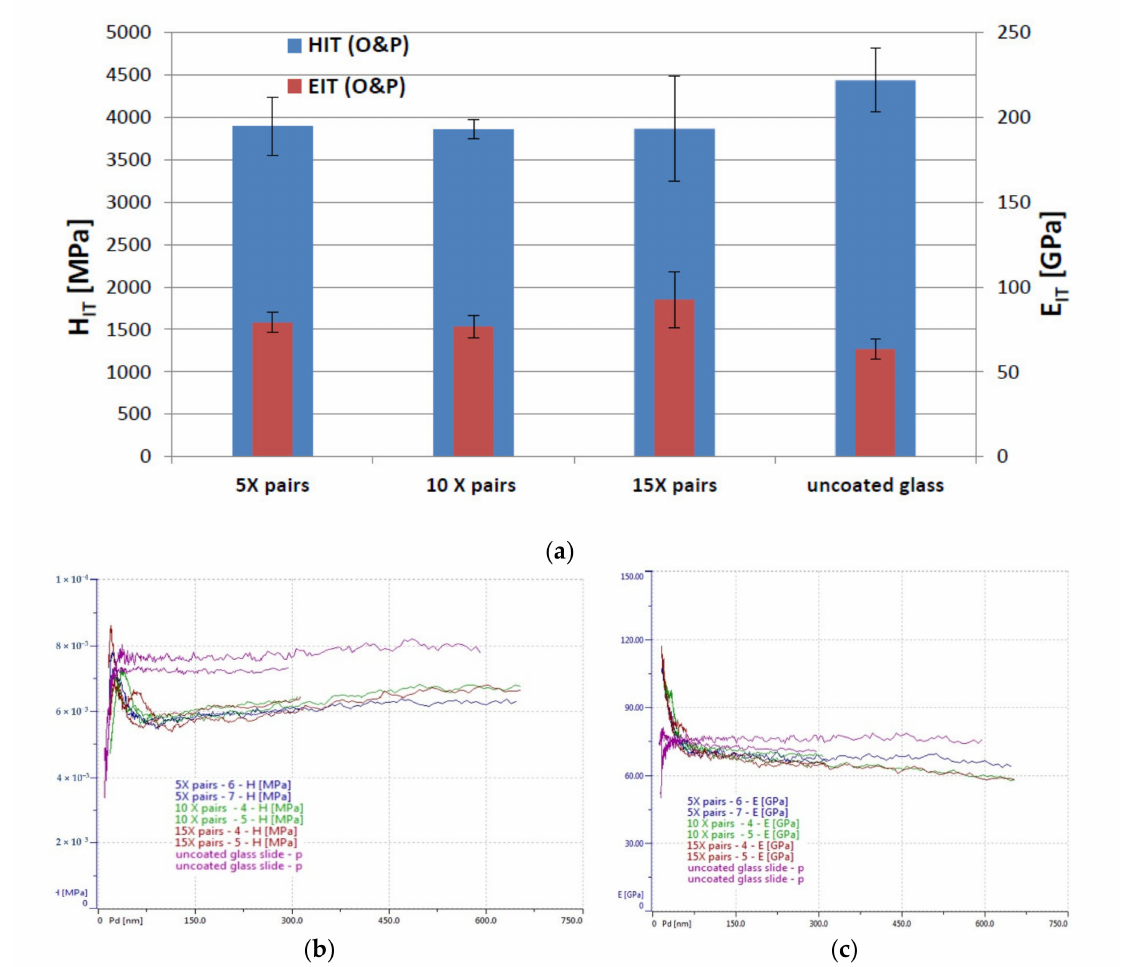
Figure 3. Indentation Testing Results for the 5, 10 and 15 pairs of thin layers on glass, and uncoated glass. ( a ) Comparative graph illustrating the hardness and elastic modulus for the bi-layer coated samples captured during the low load testing. ( b ) Hardness [MPa] evolution with depth curves (2 × 10 − 3 refers to 2000 MPa and 1 × 10 − 4 refers to 10,000 MPa). ( c ) Elastic modulus [GPa] evolution with depth